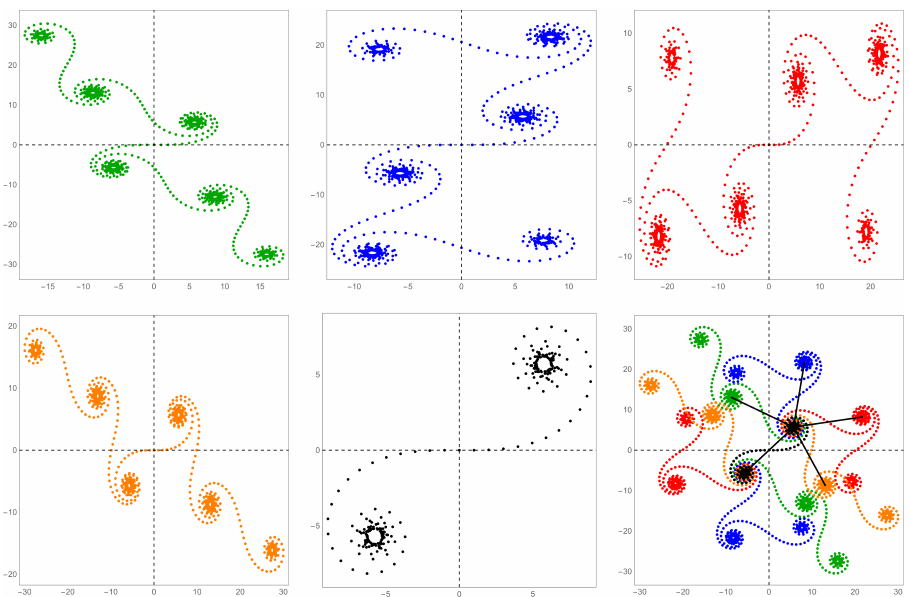
Figure 3. Analog to Figure 2 for the cases of F n ,5 where n runs from 651 to 655. The canonical shapes each have q = 5 Cornu spirals except for 655 into which five divides. The bottom right panel shows the members of this canonical family superimposed on one another. Now the local quasi-symmetry is five-fold. The black pentifoil guides the